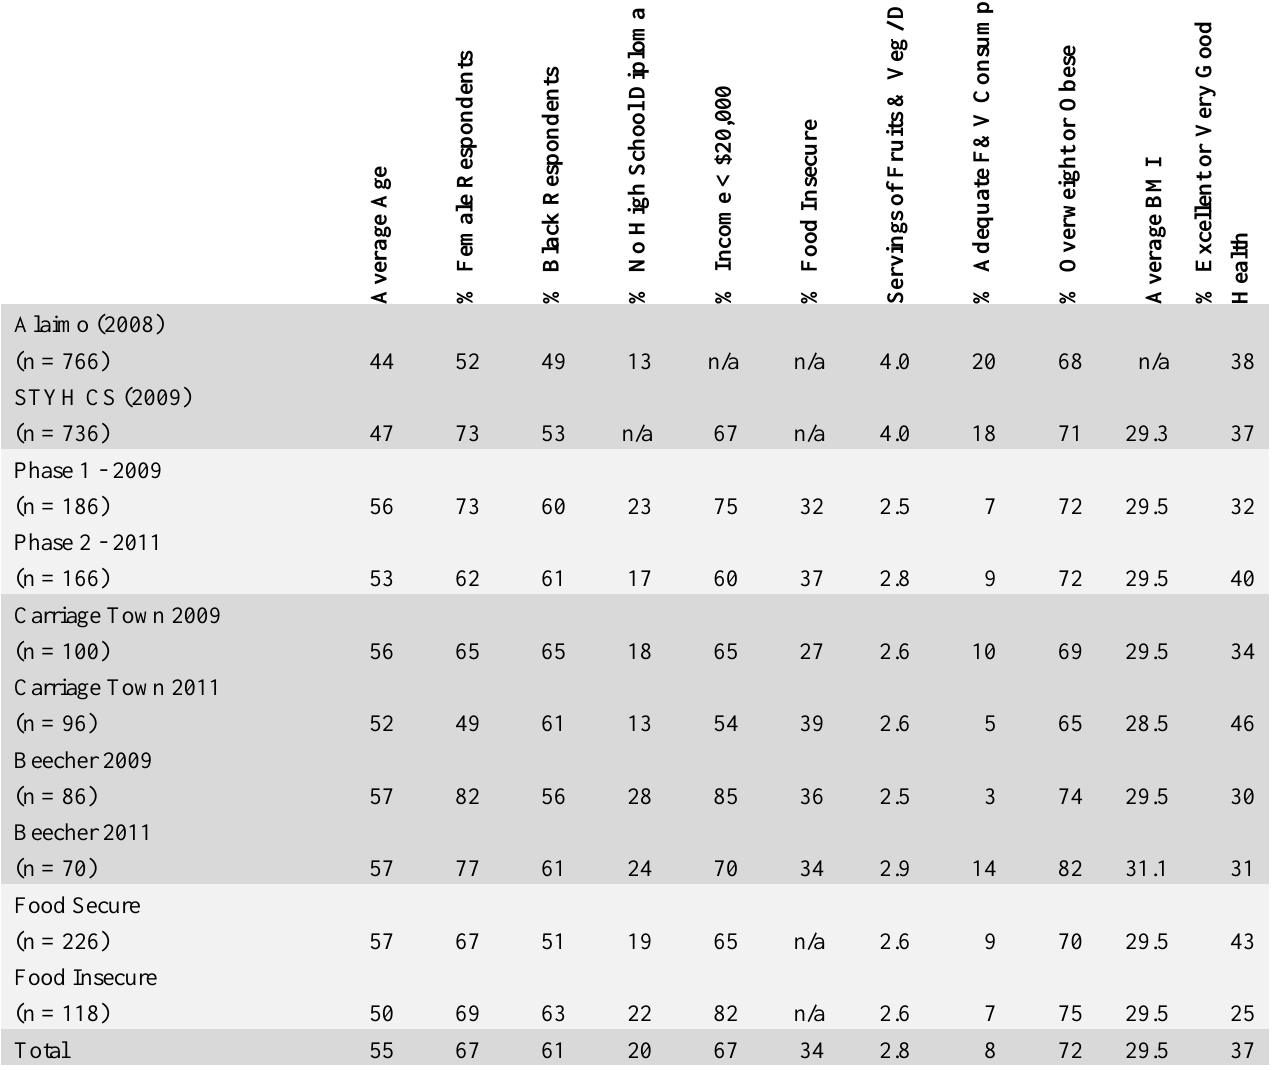
Table 1. Descriptive statistics of present research and past community